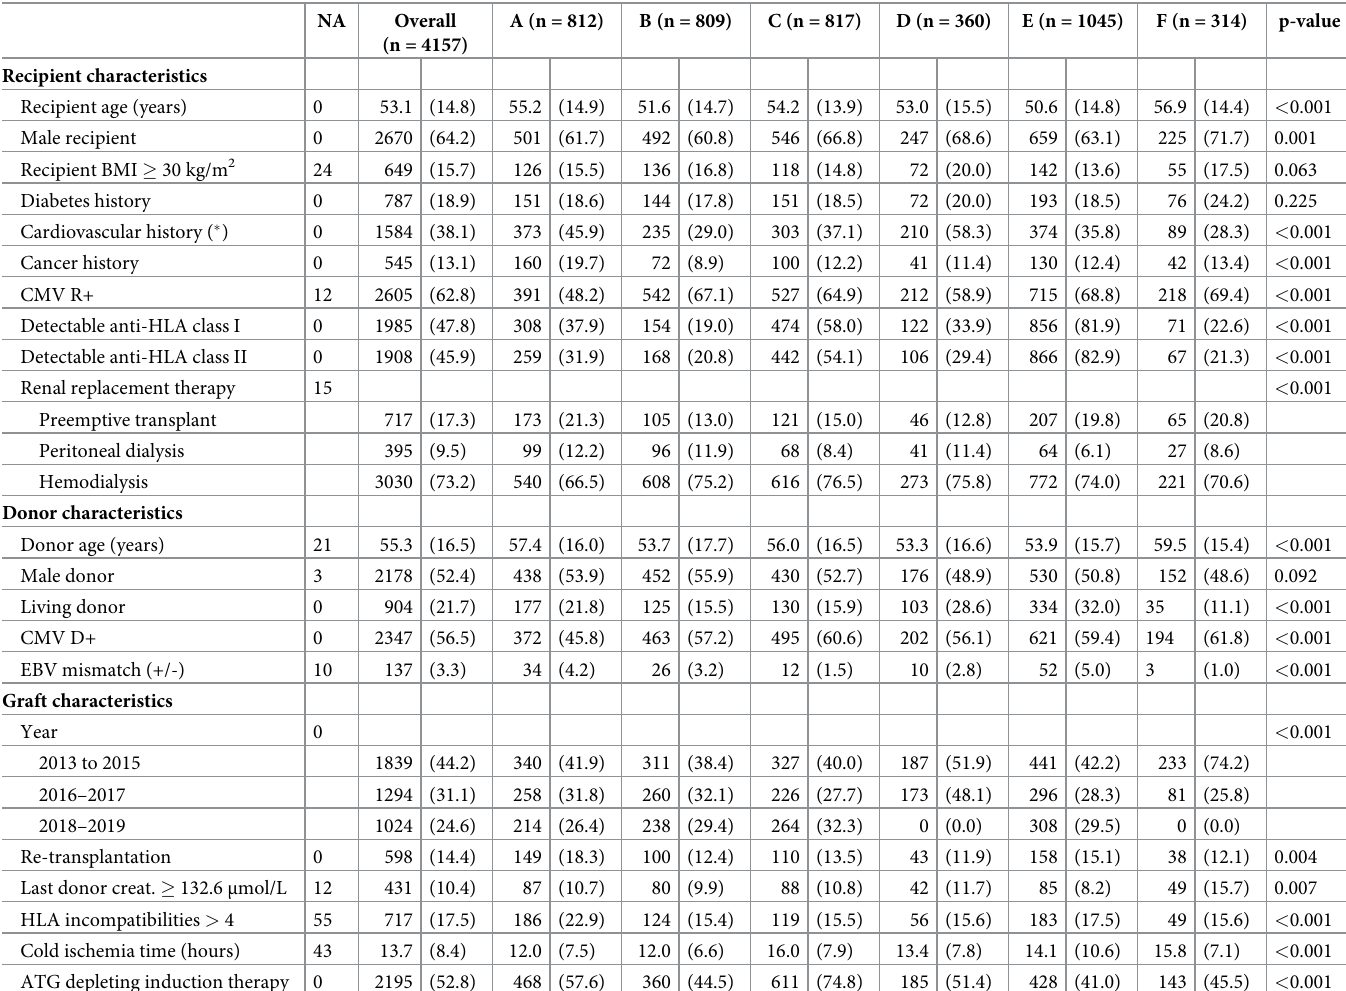
Table 1. Cohort characteristics according to the six